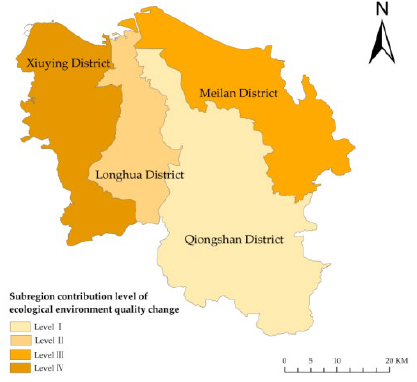
Figure 8. Sub-region contribution level of the change in the eco-environment quality in Haikou, China, from 2009 to 2018.